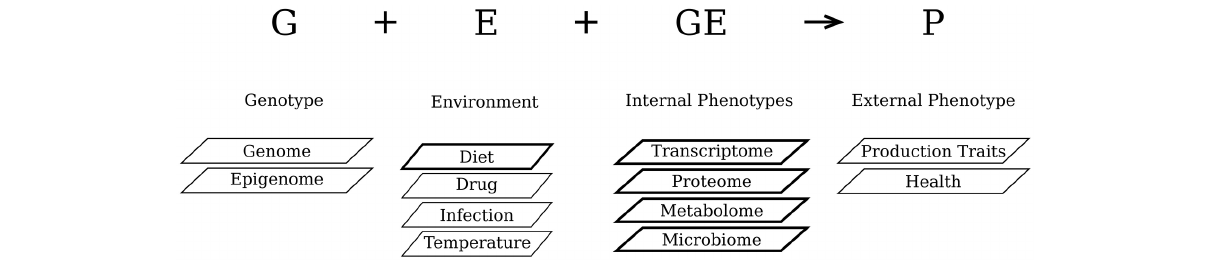
FIGURE 1 | Relationship between the external phenotype (P), the genotype (G), the environment (E), and the G&E interactions. The internal phenotypic layers and the environmental factor with a darker outline are included in the present